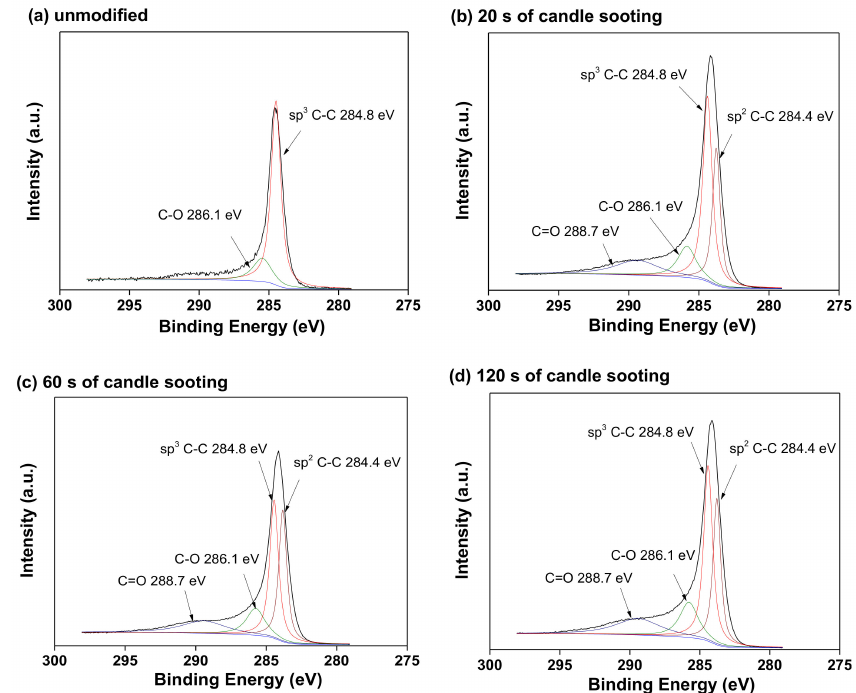
Figure 6. C 1 s XPS of the surfaces of the ( a ) unmodified carbon cloth and those modified by candle sooting for ( b ) 20 s, ( c ) 60 s, and ( d ) 120 s.